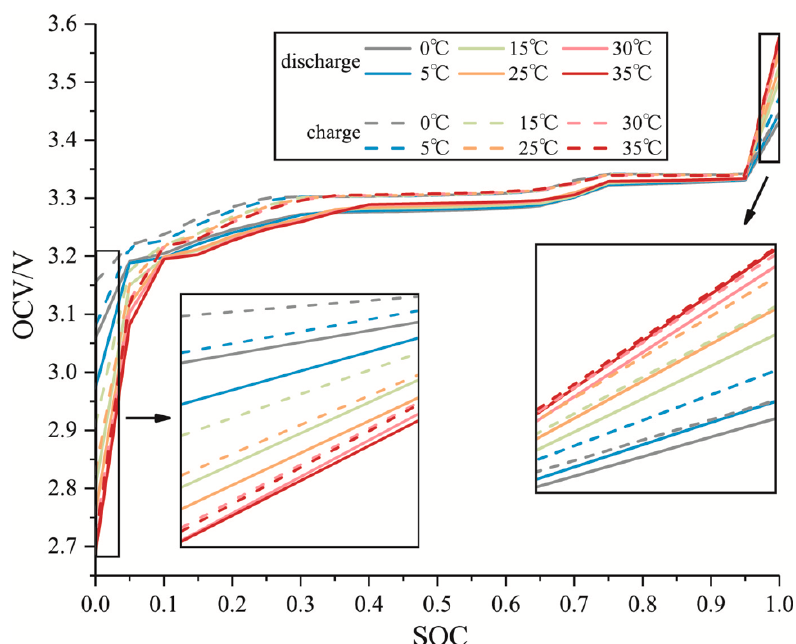
Figure 7. Open-circuit voltage as a function of the state of charge (SOC) at different temperatures in the range 0–35 °C for the A123 battery. Table 1. Results obtained from fitting of the polynomial in Equation